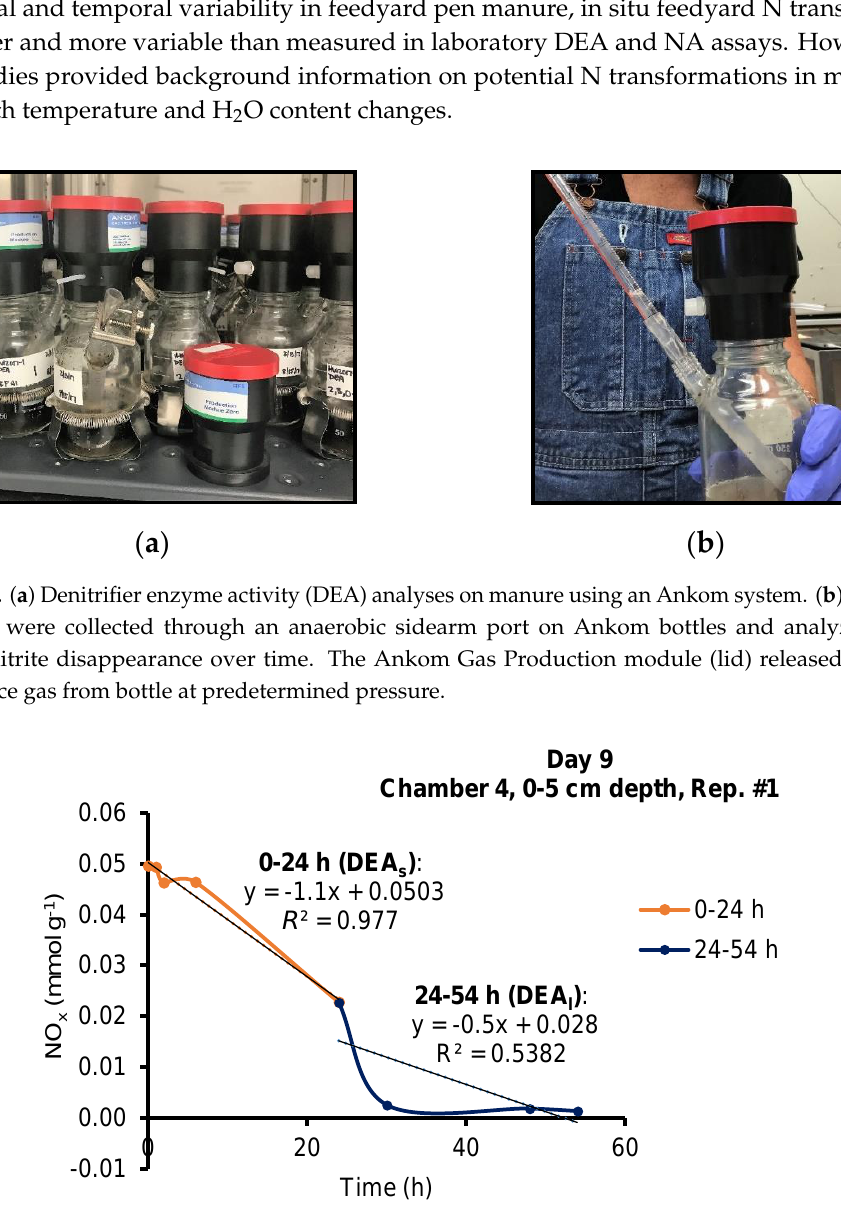
Figure 5. Example curve of nitrate/nitrite (NO x ) loss for denitrification enzyme activity (DEA) studies. There were clear bimodal trends for all plots, where DEA rates changed after 24 h. Thus, DEA rates